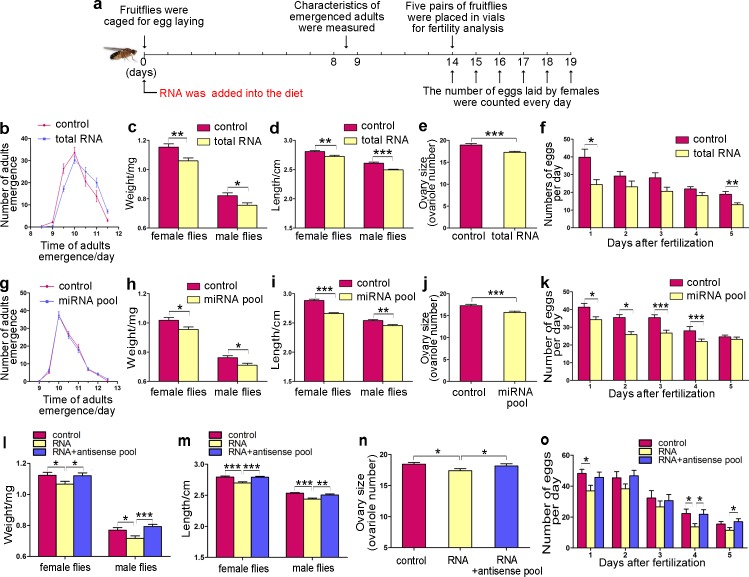
Effects of plant RNA and plant miRNA pool on Drosophila phenotypes.(a) Flow chart of the experimental design. (b-f) Developmental time (b), body weight (c), body length (d), ovary size (e) and fecundity (f) of Drosophila reared with control medium (equal volume of DEPC water added) or medium containing total pollen RNA (n = 25–35). Data are represented as the mean ± SEM. *p < 0.05; **p < 0.01; ***p < 0.001, Student’s t-test. (g-k) Developmental time (g), body weight (h), body length (i), ovary size (j) and fecundity (k) of Drosophila reared with control medium or medium supplemented with the synthetic miRNA pool (n = 25–35). Data are represented as the mean ± SEM. *p < 0.05; **p < 0.01; ***p < 0.001, Student’s t-test. (l-o) Body weight (l), body length (m), ovary size (n) and fecundity (o) of Drosophila reared with control medium or medium supplemented with pollen RNA or with pollen RNA plus a plant antisense miRNA pool (n = 25–35). Data are represented as the mean ± SEM. *p < 0.05; **p < 0.01; ***p < 0.001, one-way ANOVA.